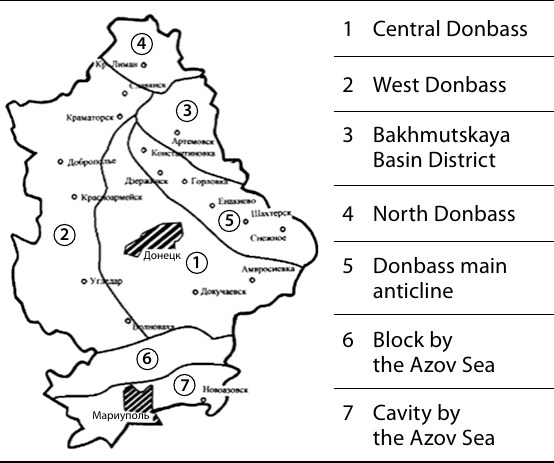
Table 5. Scheme of the engineering and geological mapping of the Donetsk